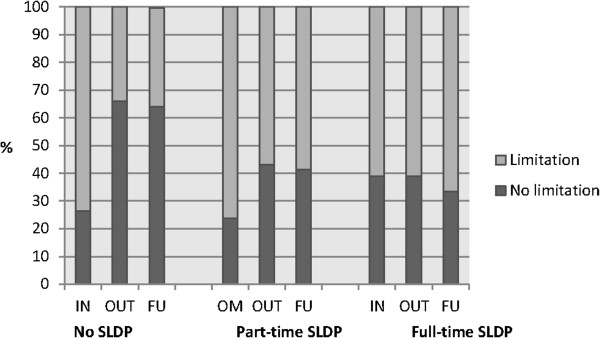
Self-reported work ability at multimodal rehabilitation (MMR) start, completed MMR and at three month follow-up. Self-reported work ability (limited or not limited) the last week, while at work and due to pain, at multimodal rehabilitation (MMR)start (IN), completed MMR (OUT) and follow up (FU) in employed/self-employed patients with no, part-time or full-time sick leave/disability pension (SLDP) the year before MMR. No SLDP: n = 87 (IN), n = 88 (OUT), n = 93 (FU); Part-time SLDP: n = 151 (IN), n = 144 (OUT), n = 140 (FU); Full-time SLDP: n = 18 (IN), n = 18 (OUT), n = 15 (FU).